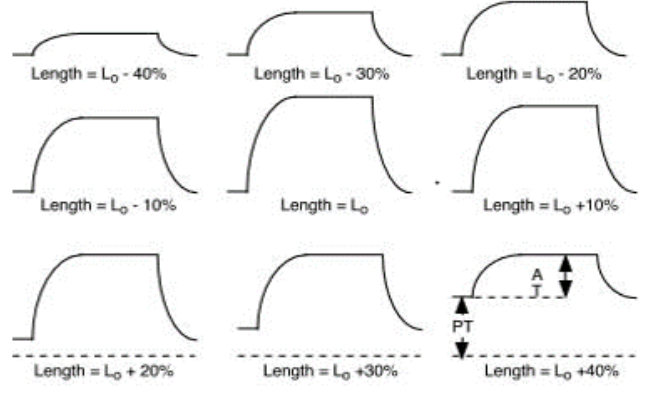
Figure 4. A series of isometric contractions performed at different muscle